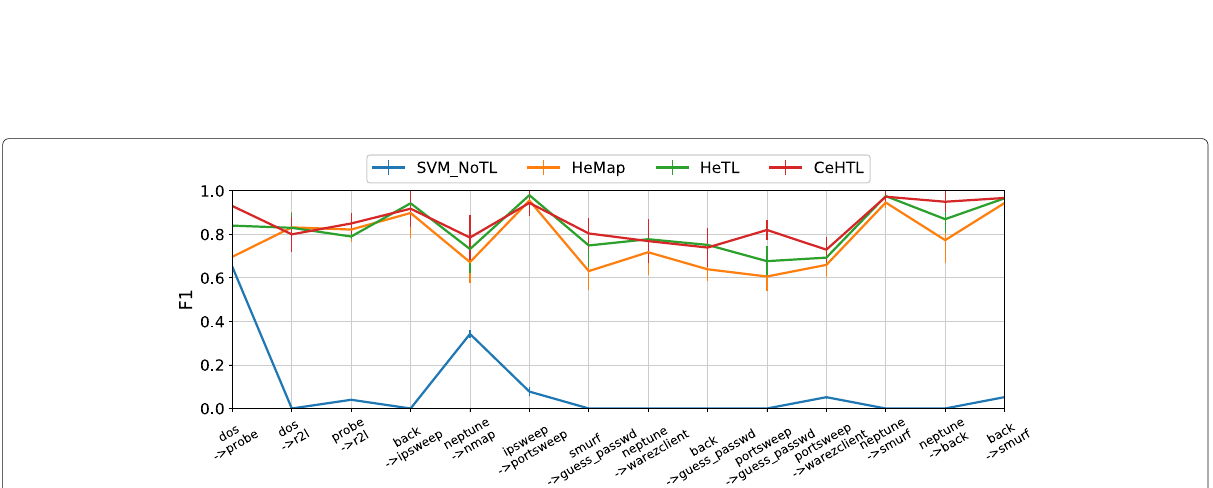
Fig. 5 Performance comparison of F 1 score on unknown network attacks detection, sample size = 1000